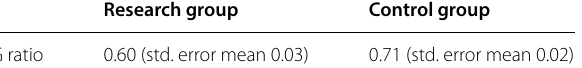
axonal myelination and function of the femoral nerve, the use of alendronate in Wistar rats in dosage sug- gested for human patients can be considered a distinct